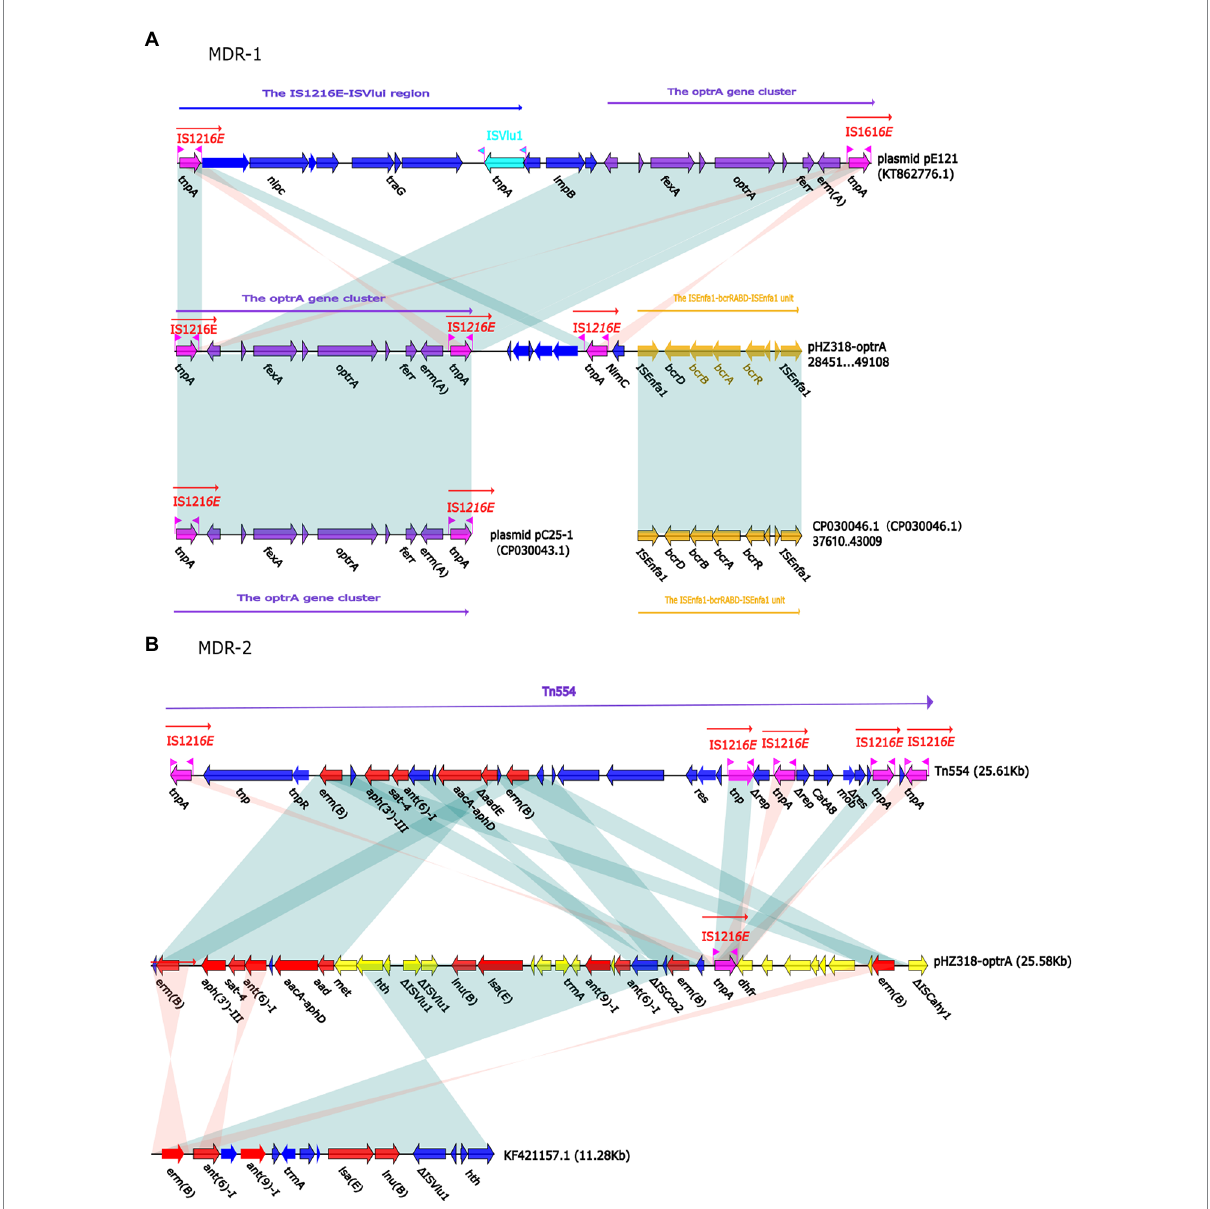
FIGURE 7 (A) The organization and alignment of MDR-1 region of pHZ318-optrA. (B) The organization and alignment of MDR-2 region of pHZ318-optrA. Genes are indicated by arrows. Genes, mobile elements, and other features are colored based on functional classification. Shadows indicate nucleotide homology is greater than 95%. The number in parentheses indicates the location of the fragment in the